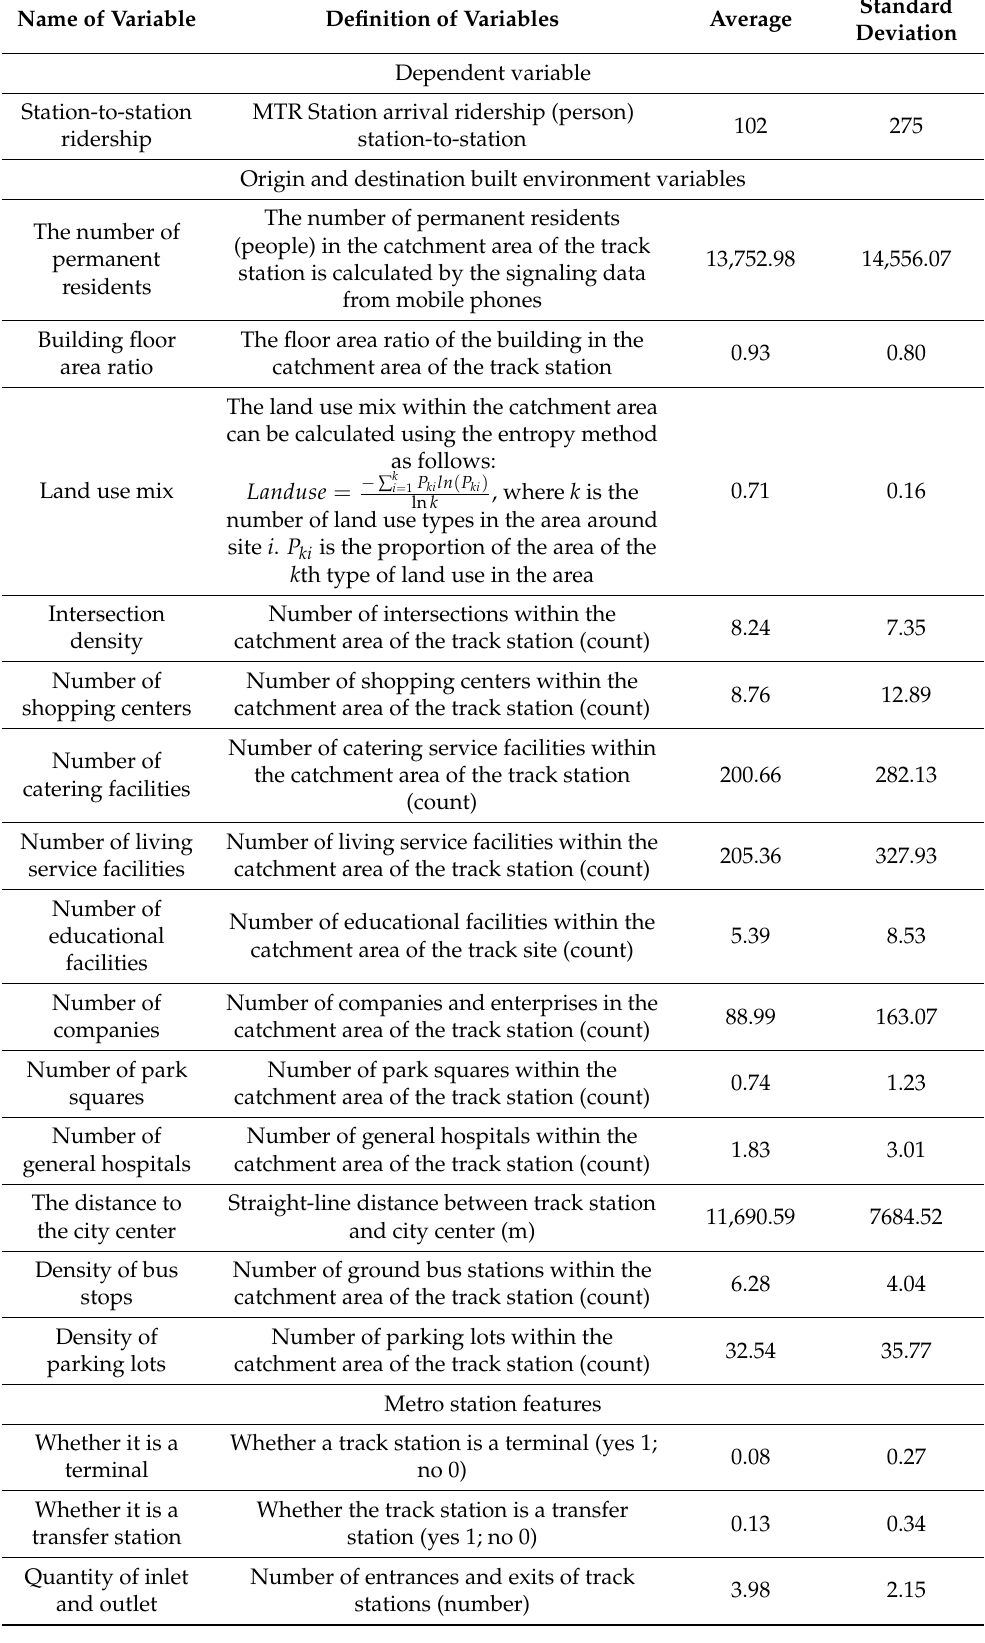
Table 1. Variable definitions and data